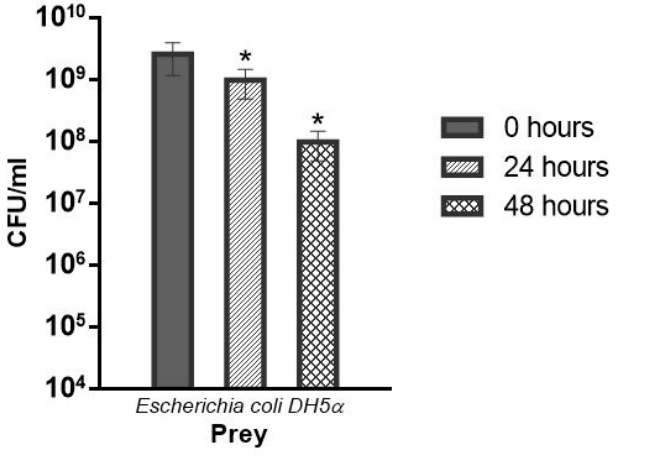
Figure 8. Viability of Escherichia coli DH5 α (CFU/mL) in co-cultivation with Bdellovibrio bacteriovorus HD100. * The cell counts were significantly reduced ( p < 0.05) after 24 and 48